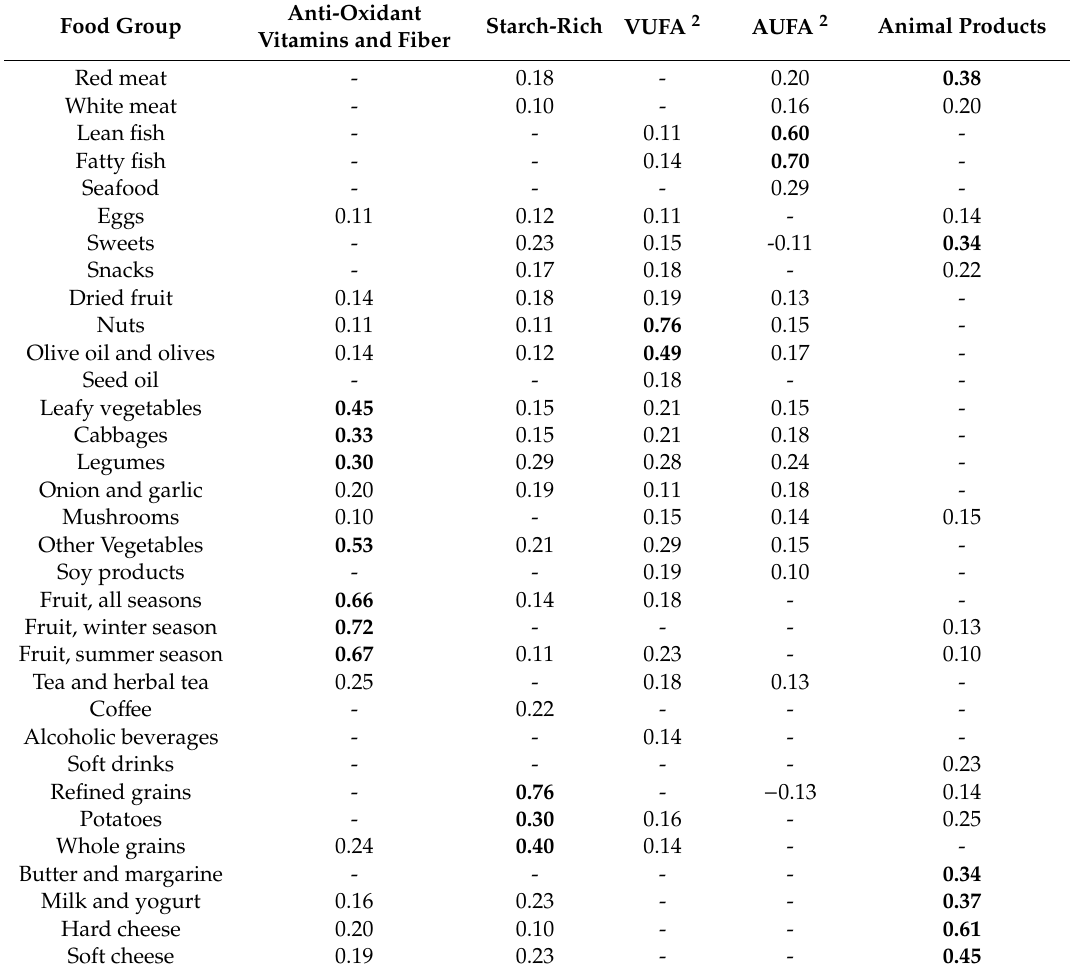
Table 2. Spearman rank correlation coe ffi cients 1 between nutrient-based dietary patterns (factor scores) derived from principal component factor analysis and daily frequencies of consumption for selected food groups and condiments derived on the same data.